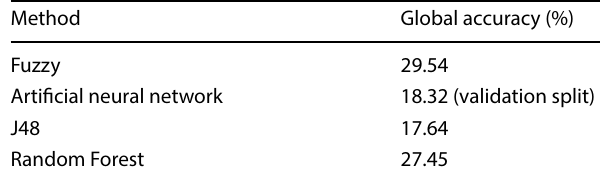
Table 3 Overall accuracy of the four methods applied Method